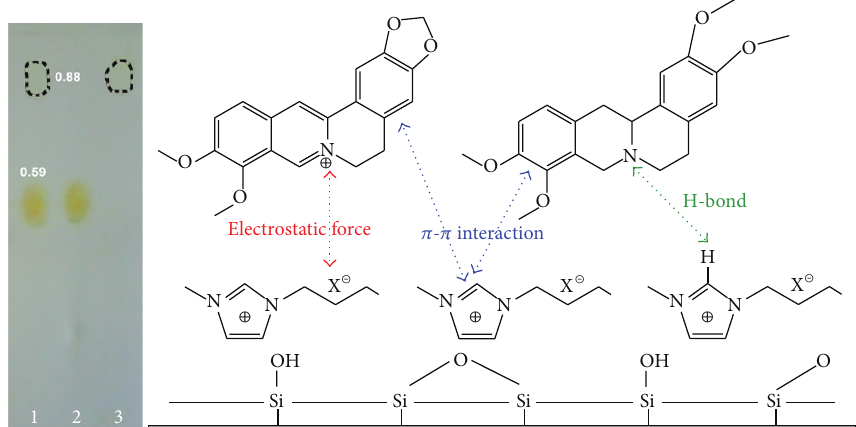
Figure 1: TLC chromatogram with [BMIM]OH:methanol (1:20, v/v) as developing reagent and separation mechanism (1: mixture of berberine hydrochloride and tetrahydropalmatine, 2: berberine hydrochloride, and 3: tetrahydropalmatine).